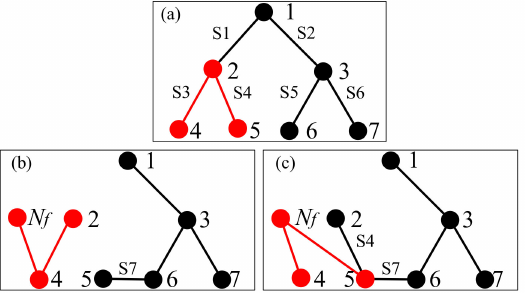
Figure 8. The comparison of di ff erent scenario of failure restoration. ( a ) The faulty topology, ( b ) The restored topology with consideration of load priority, ( c ) The restored topology without consideration of load